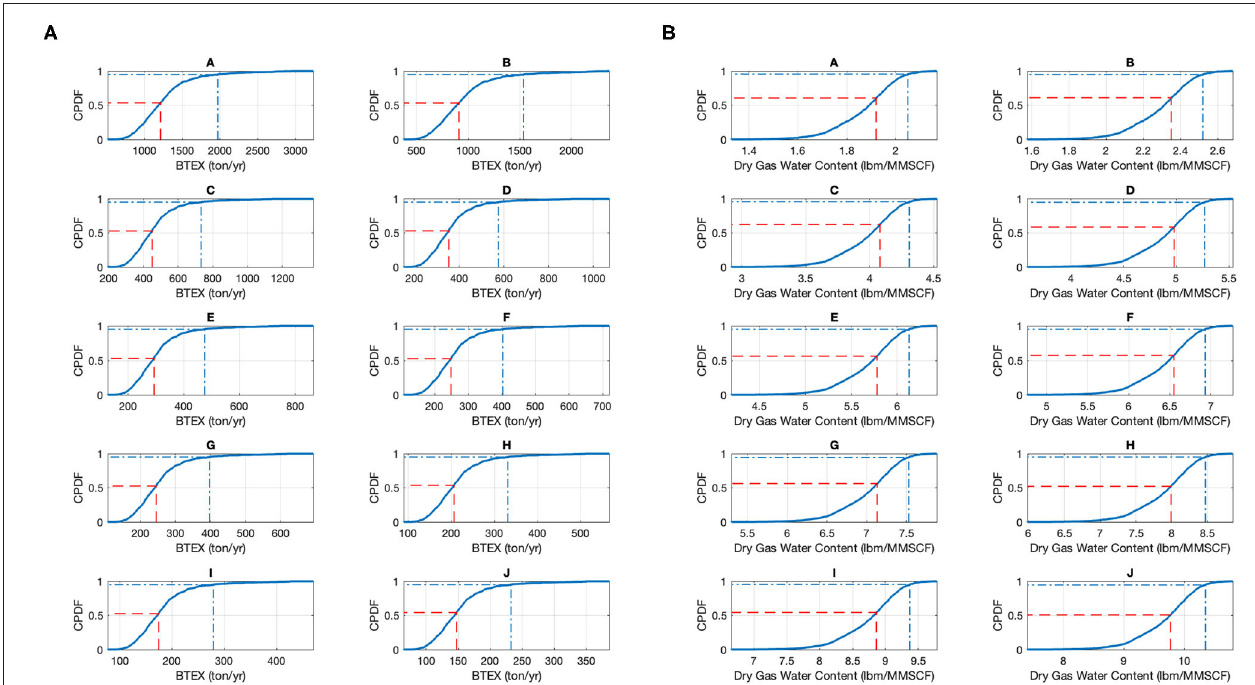
FIGURE 5 | (A) Probability distribution of BTEX emission from uncertain NG process feed compositions generated with 500 sample points at the 10 Pareto optimal points from deterministic solution. The reliability of the system when BTEX emission is less than the amount as given in Table 1 lies between 0.54 and 0.53 % ; (B) Probability distribution of dry gas water content from uncertain NG process feed compositions generated with 500 sample points at the 10 Pareto optimal points from deterministic solution. The reliability of the system when dry has water is less than the amount as given in Table 1 lies between 0.62 and 0.51 %